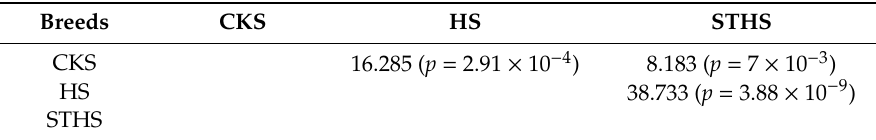
Table 3. The chi-square test of CNV types among Chinese sheep breeds.